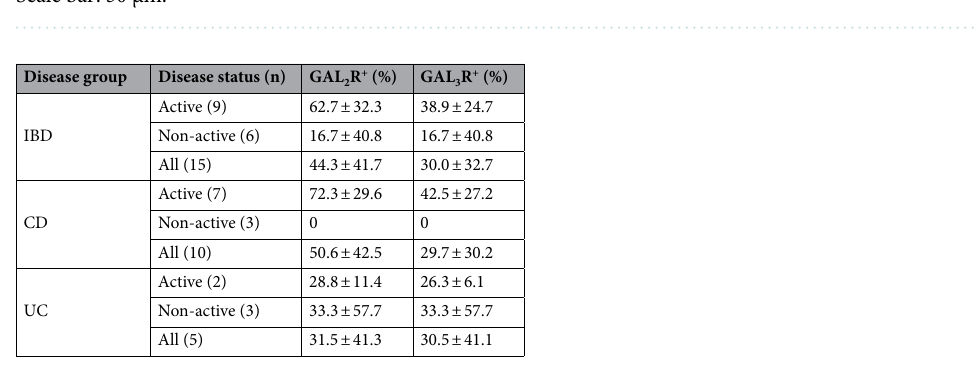
Figure 1. Representative images of IHC staining of human colon specimens of patients diagnosed with Crohn’s disease [CD; case 15 ( a ), case 16 ( d ), case 18 ( g )] or ulcerative colitis [UC; case 25 ( b , e , h )] and healthy individuals [case 9 ( c , f , i )] for GAL 1 R ( a – c ), GAL 2 R ( d – f ) and GAL 3 R ( g – i ). Arrowheads indicate GALR- negative and arrows GALR-positive granulocytes. A negative control with second antibody only is shown ( j ). Scale bar: 50 µm.